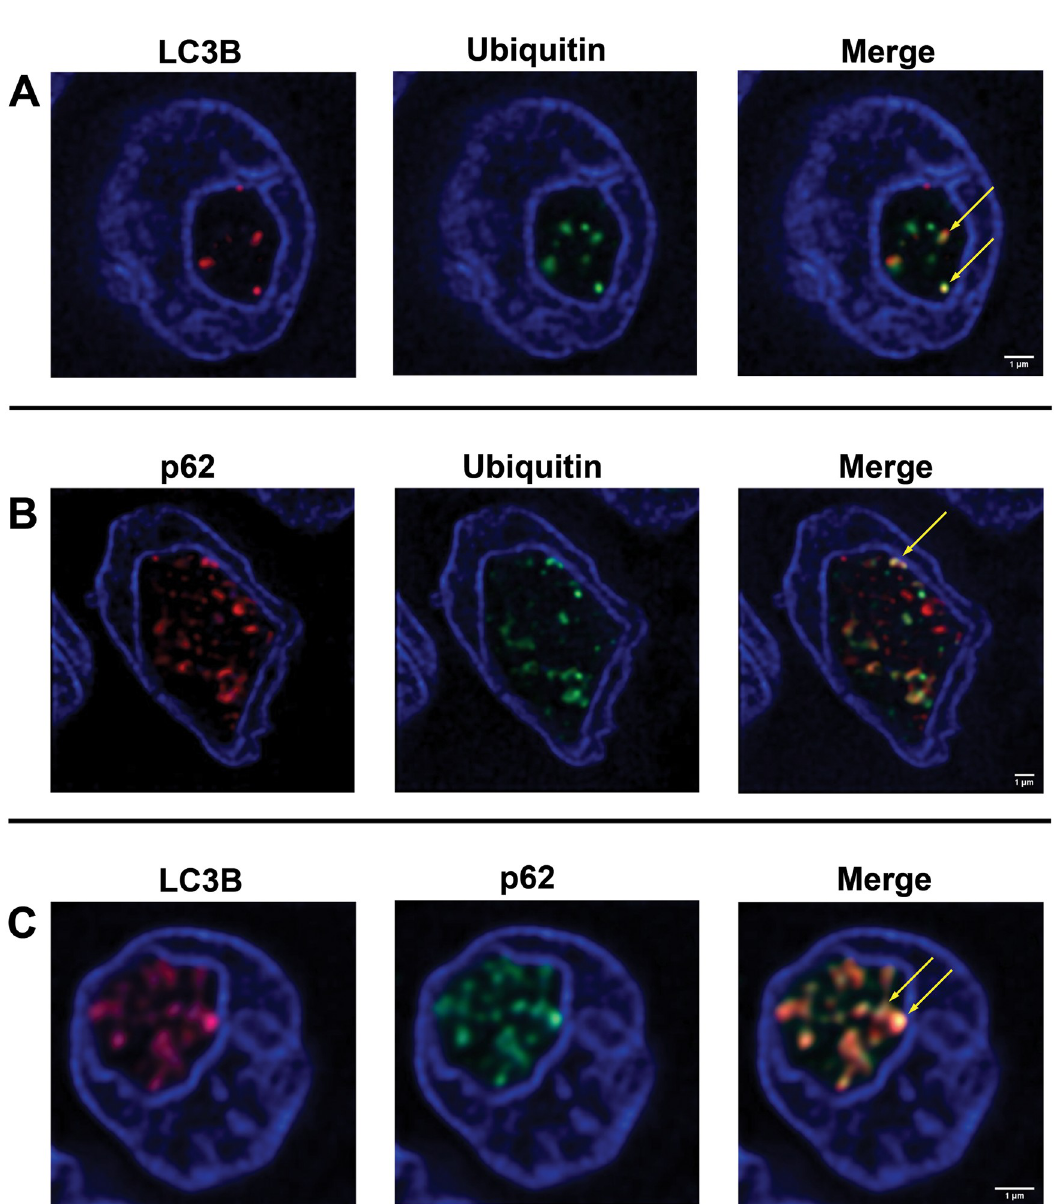
Fig 4. Double-IF studies of autophagy-associated proteins in PTC sections. (A) LC3B/ubiquitin double-IF labeling. DAPI staining (blue) reveals a nucleus with an intranuclear inclusion containing LC3B (red) and ubiquitin (green) immunostaining. The superimposition of both signals results in yellow color (arrows, merged image) proving a co-localization of the two proteins. (B) p62/ ubiquitin double-IF labeling. An intranuclear inclusion with tense accumulation of p62 (red staining) and ubiquitin (green staining) is seen; yellow staining (arrow) in the merged image indicates p62/ubiquitin co-localization. (C) LC3B/p62 double-IF labeling. The images show strong LC3B (red staining) and p62 (green staining) immunoreactivity in the inclusion. There is strong LC3B/p62 co- localization displayed by the intense yellow color in the merged image